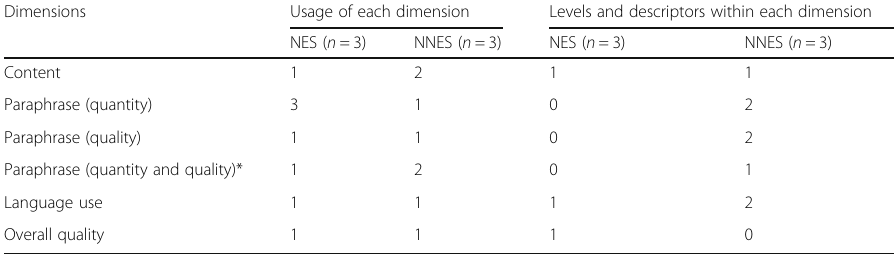
Table 1 Components of the raters ’ comments Dimensions Usage of each dimension